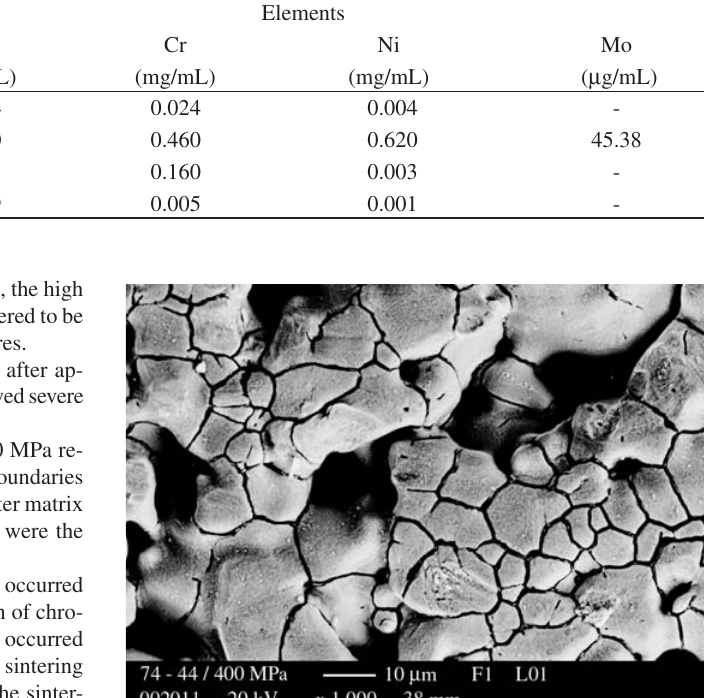
Table 3. Elements leached from AISI 316 filters into naturally aerated 0.5 M H troscopy.